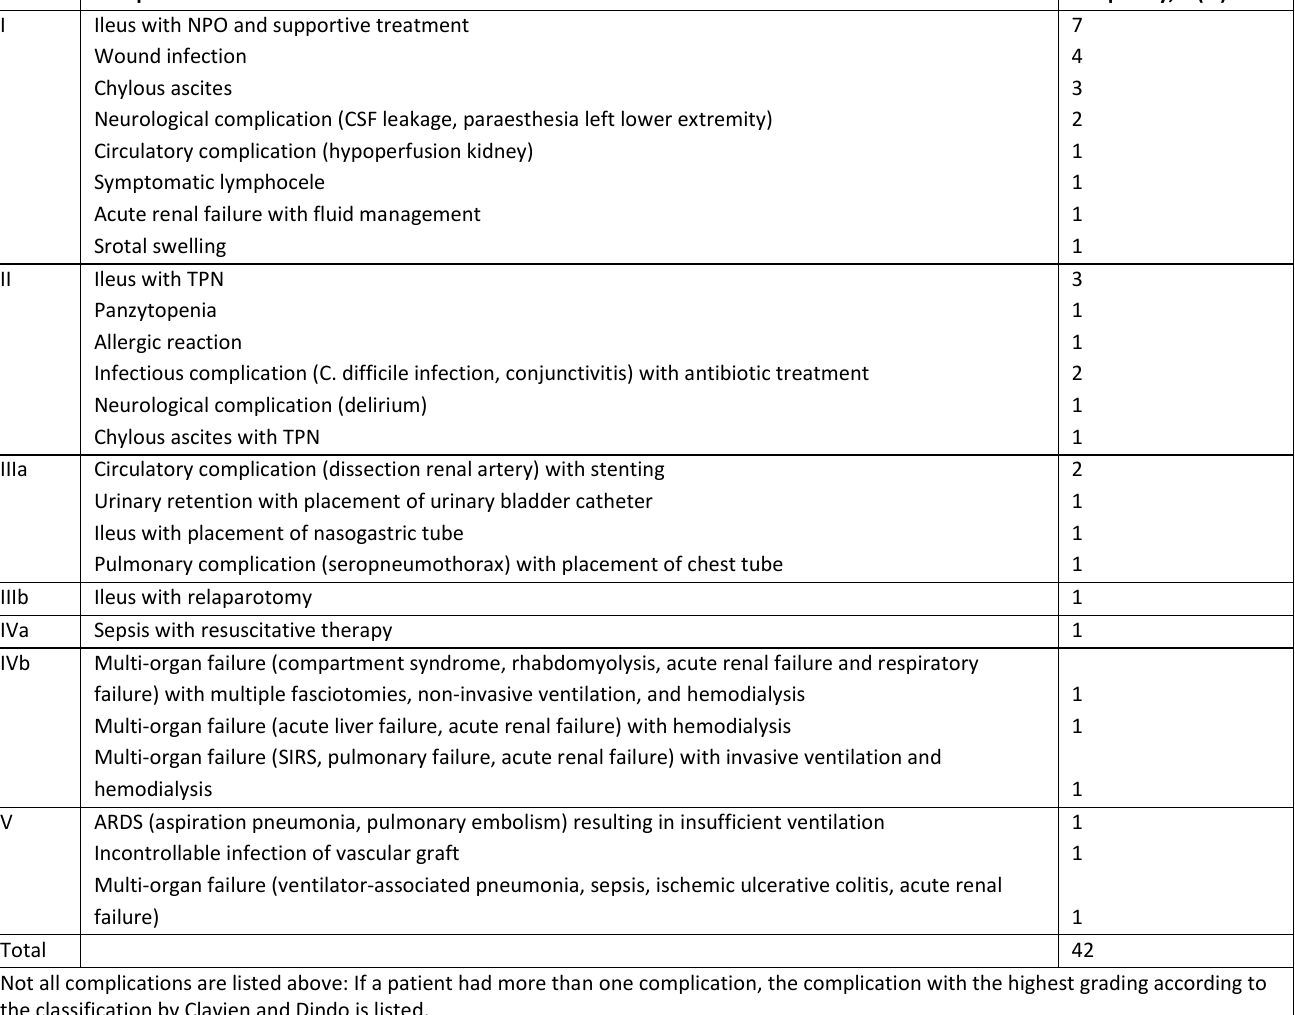
Supplementary table 7.3. Postoperative complications classified according to Clavien-Dindo.